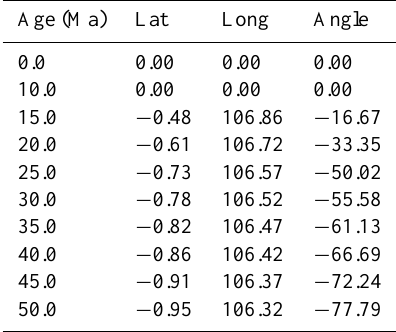
Table 4. Finite Euler rotations interpolated in 5Myr intervals for Borneo relative to Sumatra derived from our oroclinal bending model for